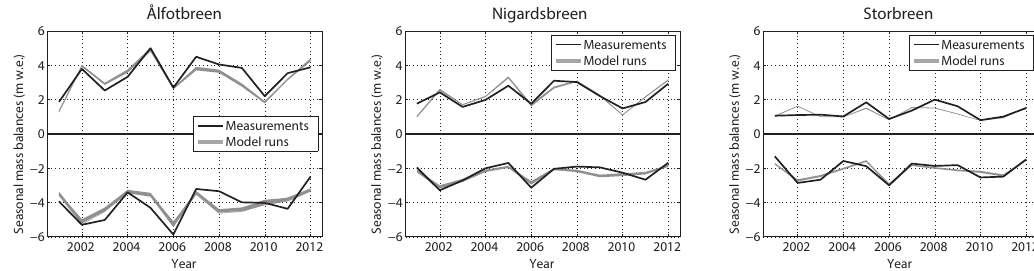
Fig. 4. Model performance for seasonal glacier mass balances for the three catchments for the validation period 2001-2012.